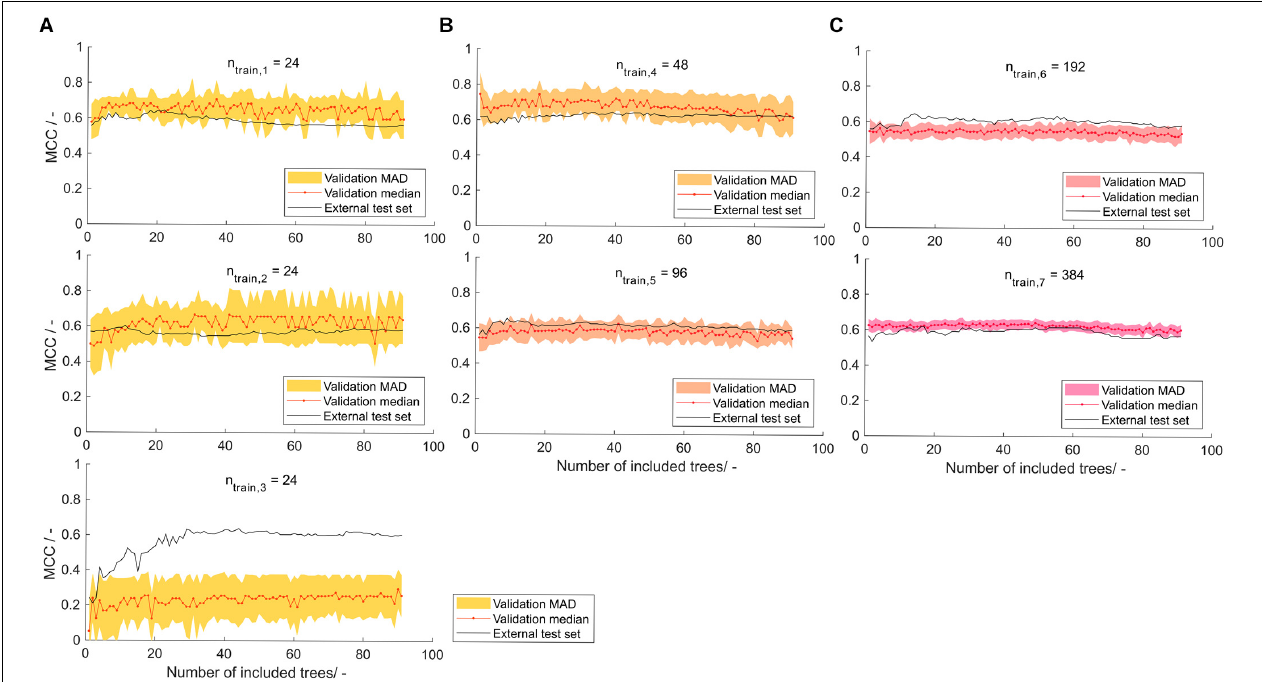
FIGURE 5 | Validation and external test set Matthew’s correlation coefficient (MCC) on stratified training data with training set size of (A) 24, (B) 48 and 96, and (C) 192 and 384 observations, depending on the number of included decision trees. Validation median and median absolute deviation (MAD) are calculated from 100-fold Monte Carlo cross-validation. The median is shown as red dots connected by a line to guide the eye. The shaded area represents the MAD around the median and are colored from yellow over orange to pink with increasing training set size. The black line represents the performance of the model on the external test set of size n test = 568 − n train